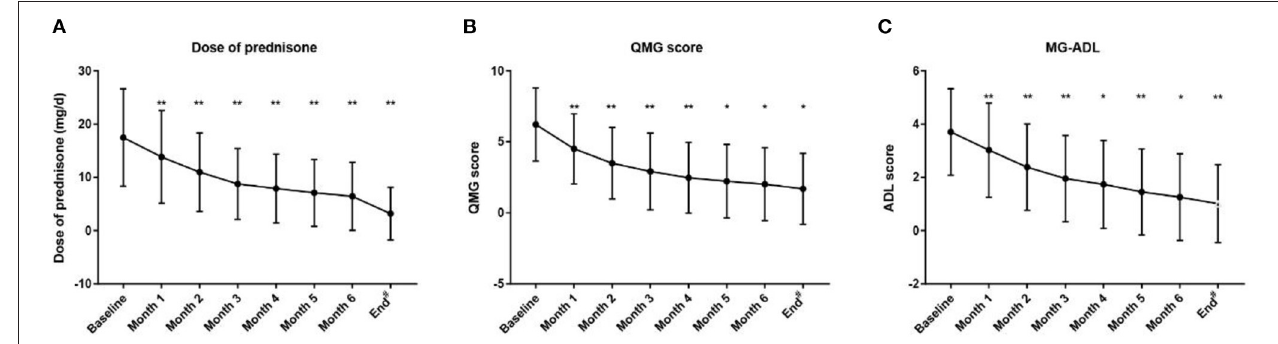
FIGURE 3 | Changes of the prednisone dose, QMG score and MG-ADL score during treatment with tacrolimus. # Mean follow-up of 3.16 ± 1.33 years (range 1.24–7.18 years). ADL, activity of daily living; QMG, quantitative MG. (A) Dose of prednisone, (B) QMG score, (C) MG-ADL score decreased gradually after initiation of tacrolimus treatment during the 6-month following-up (Dose of prednisone were 17.47 ± 9.16, 13.83 ± 8.69, 10.97 ± 7.38, 8.74 ± 6.65, 7.87 ± 6.46, 7.08 ± 6.28, 6.42 ± 6.39, 3.17 ± 4.93; QMG scores were 6.22 ± 2.58, 4.50 ± 2.47, 3.50 ± 2.52, 2.91 ± 2.71, 2.47 ± 2.49, 2.22 ± 2.59, 2.01 ± 2.57, 1.68 ± 2.49; and ADL scores were 3.70 ± 1.63, 3.02 ± 1.77, 2.38 ± 1.62, 1.95 ± 1.62, 1.73 ± 1.65, 1.45 ± 1.61, 1.26 ± 1.63, 1.01 ± 1.46 at the start of acrolimus treatment, 1, 2, 3, 4, 5, 6 month and the end of follow-up; respectively) (Compared with the last follow-up time point, * P < 0.05, ** p < 0.001; 2-tailed Wilcoxon signed-rank test). * p < 0.05. ** p < 0.01.